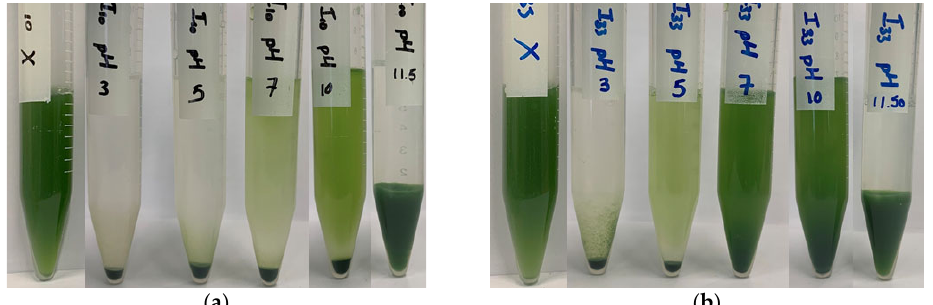
Figure 3. Comparison of the effects of different pH and salinity conditions on 18 h auto-flocculation and sedimentation process for Tetraselmis sp.: ( a ) 10‰ salinity medium, ( b ) 33‰ salinity medium (tubes from left to right: initial 5 mL cell culture at start, pH 3, pH 5, pH 7, pH 10, pH 11.5). 3.3. Microalgal Cell Collection by Flocculation and Magnetic Separation of Nanoparticles Four different synthesized magnetic nanoparticles, i.e., bare Fe 3 O 4 , NH 2 -Fe 3 O 4 , citrate- 80C-Fe 3 O 4 , and PDDA-coated Fe 3 O 4 , were tested and compared for the microalgal cell flocculation and magnetic separation processes. Table 3 summarizes the results of floccu- lation and magnetic separation after 2 min gentle shaking at an initial pH 8.7–9.0 under different salinity conditions (i.e., 10‰ and 33‰). Table 3. Flocculation and magnetic separation of microalgal cells under different salinities. Magnetic Magnetic Magnetic Nanoparticles Salinity Nanoparticles Separation Added (mL) Time